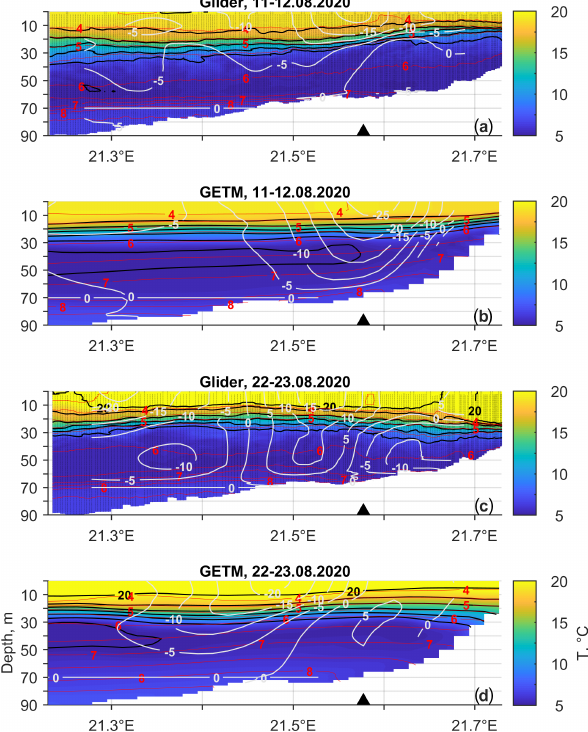
Figure 15. Temperature (color contours), density isolines (red lines), and relative geostrophic current (white lines) based on glider observations and GETM simulation on 11–12 and 22–23 August